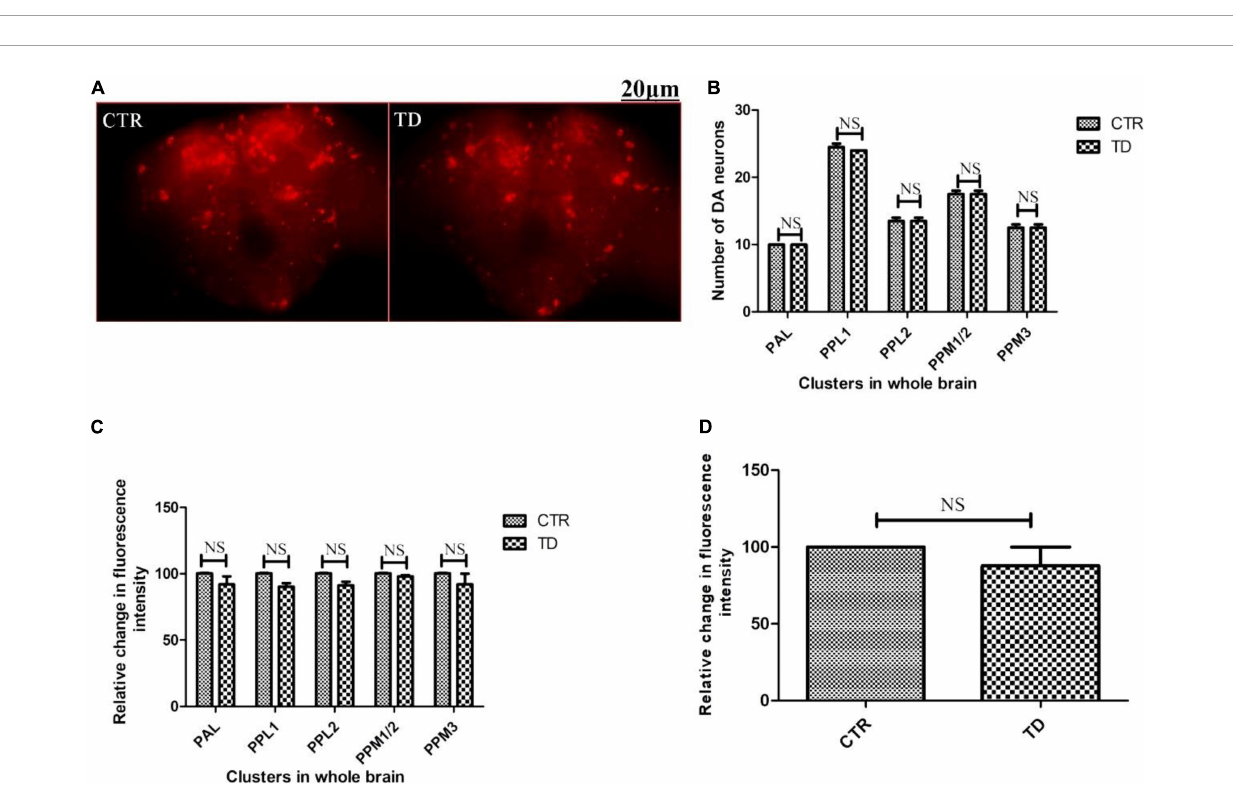
FIGURE3 Characterization of DAergic neurodegeneration in the whole fly brain of control and paraquat (PQ)-induced sexual dysfunction (SD) fly (A) through anti-TH antibody immunostaining reveals that there is no loss in the number of DA neurons per se (B) and no change in the level of TH synthesis in all the clusters (C) , and in toto (D) between the control and treated group as analyzed by quantification of fluorescence intensity of fluorescently labeled secondary antibody that targets the anti-tyrosine hydroxylase (TH) primary antibody. (CTR, control; TD, treated with 10 mM PQ; Represented images are “merged” Z-stacking images; however, the quantification of DA neuronal number and fluorescence intensity is performed in 3D Z-stack images; PAL, protocerebral anterior lateral; PPL, protocerebral posterior lateral; PPM, protocerebral posterior medial). The scale bar of the brain images in the panel is 20 µ m. Statistical analysis was performed using a t -test (compared to the control, NS,